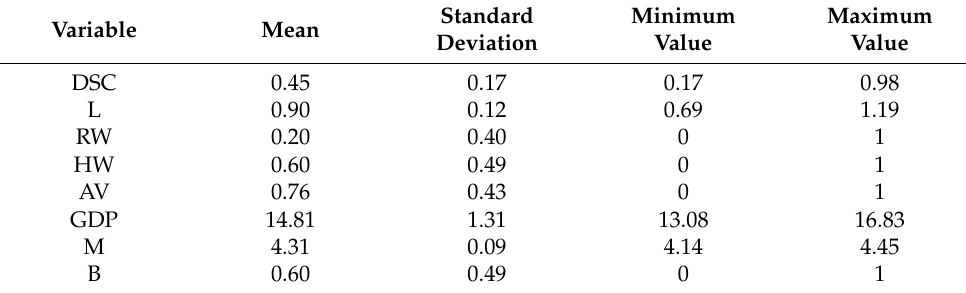
Table 2. Descriptive statistical